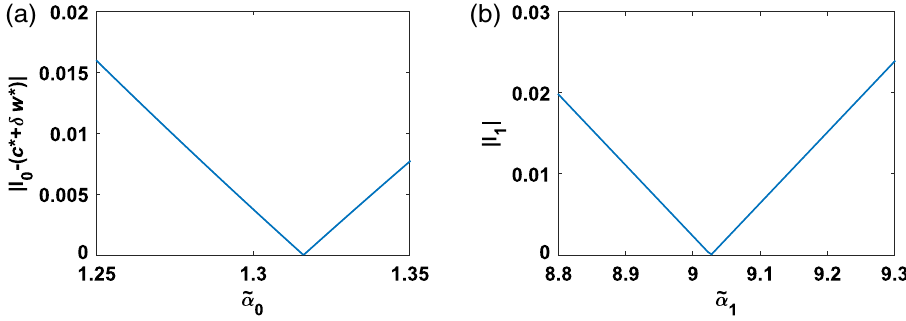
FIG. 9. Determination of the Lagrange parameter ˜ α ¼ ˜ α 0 þ ε ˜ α 1 . (a) For each value of ˜ α 0 , a 0 and b 0 are calculated and l 0 is estimated; we find that l 0 − ð c (cid:2) þ δ w (cid:2) Þ ¼ 0 for ˜ α 0 ¼ 1 . 32 . (b) For ˜ α 0 ¼ 1 . 32 , while ˜ α 1 is varied, a 1 and b 1 are calculated to estimate l 1 ; we find l 0 for ˜ α 9 . 04 1 ¼ 1 ¼